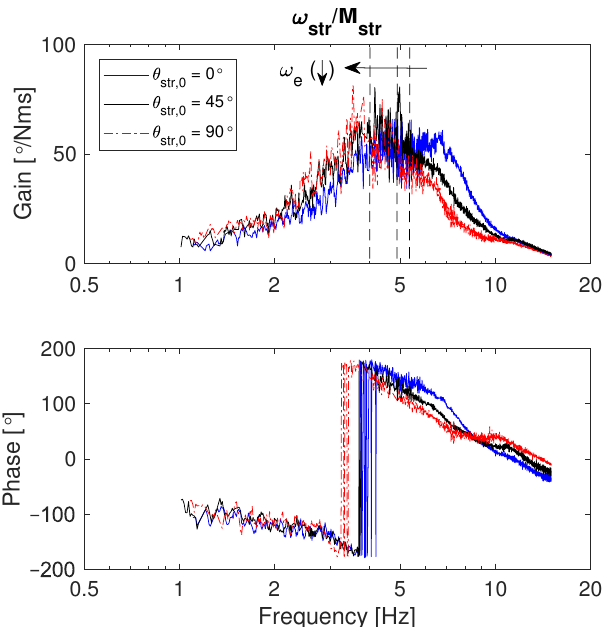
Figure 6. Measured FRF for three steering angular positions (0 ◦ ,45 ◦ and 90 ◦ ) from steering torque to steering angular